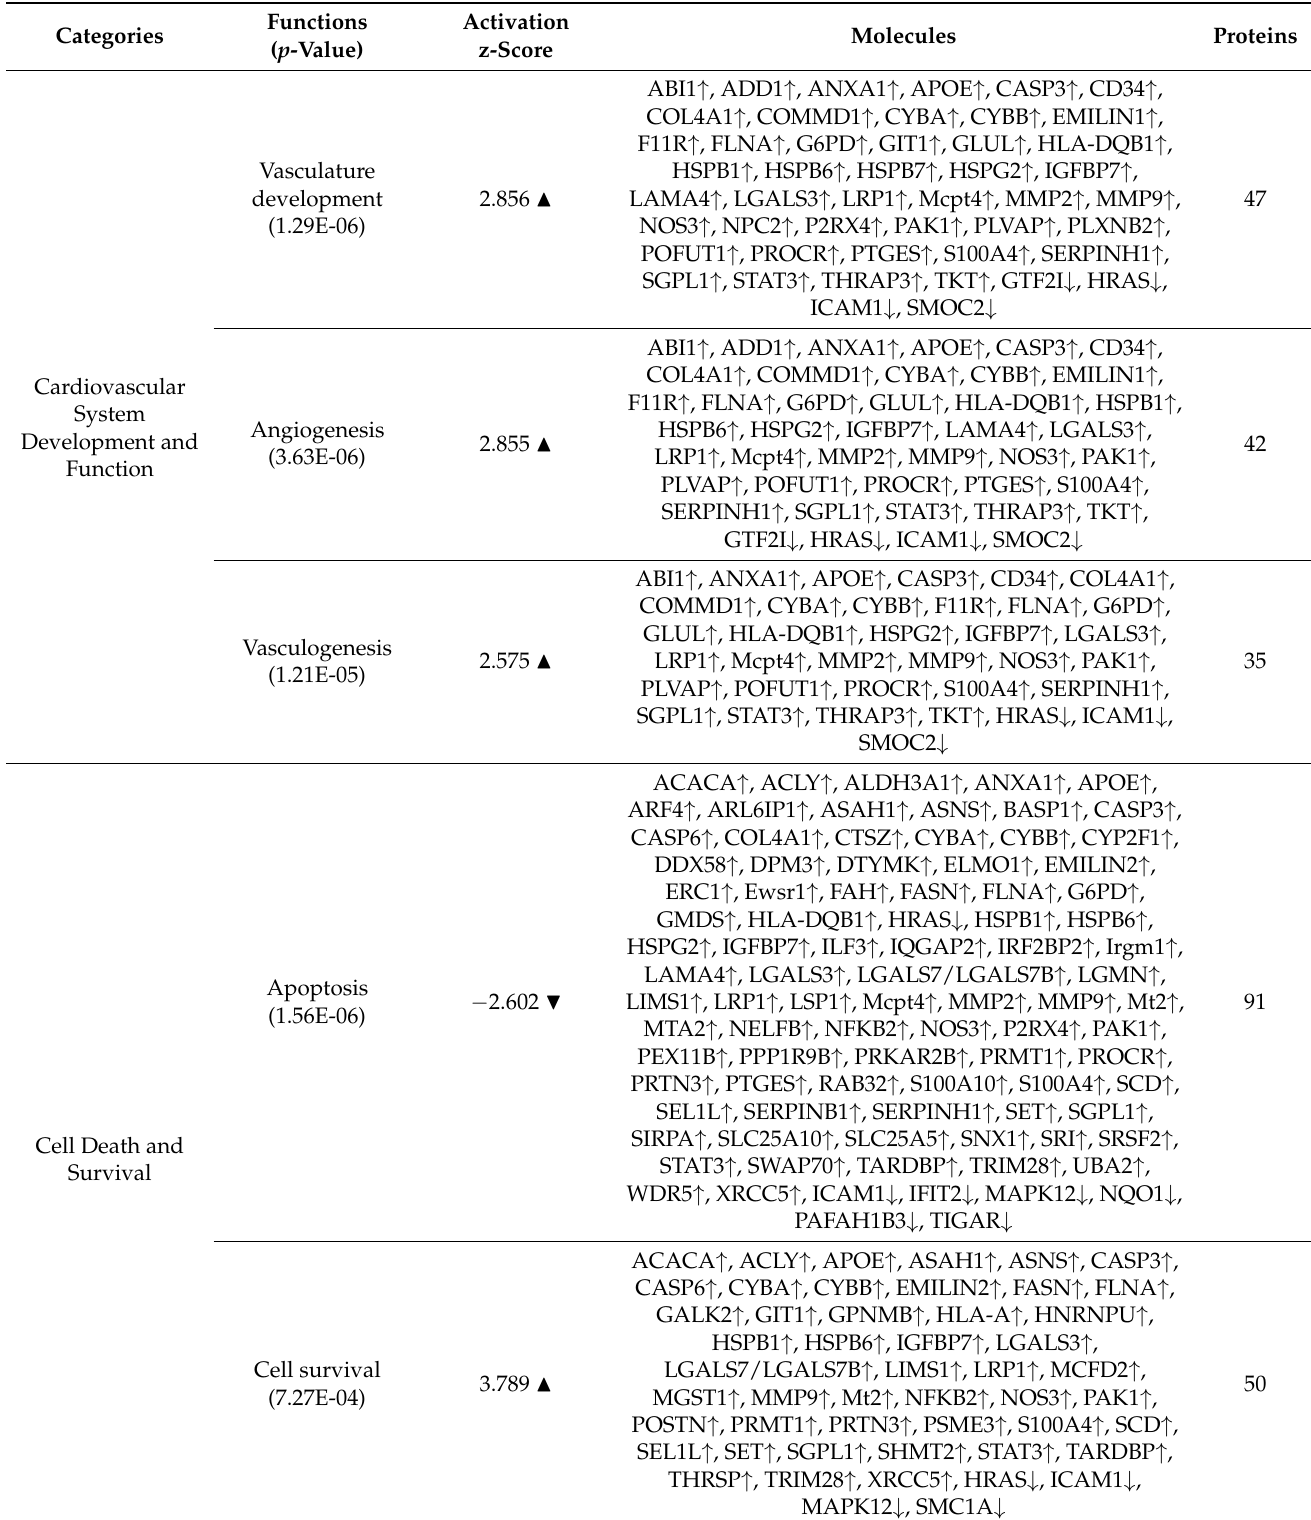
Table 1. Functional classification of protein changes due to ischemia. Protein changes in ischemic mice (SC, SE, and SF vs. shams) were classified with IPA, highlighting the most probable functions of proteins of interest. Legend: ↑ up-regulated; ↓ down-regulated; (cid:78) predicted activation increased; (cid:72) predicted activation